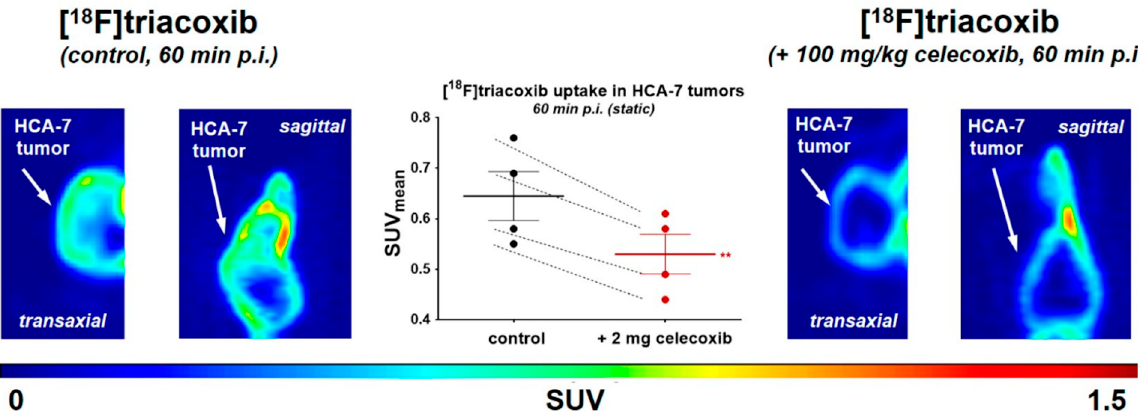
Figure 21. Transaxial and sagittal PET projection of PET images of [ 18 F]triacoxib at 60 min p.i. in the same mouse after two consecutive days under control (left) and blocking (right) conditions. Statistical analysis of the blocking effect with 2 mg celecoxib at 60 min p.i. (middle). Data are presented as individual points with the mean ± SEM from n = 4 dynamic PET experiments. ** p < 0.01. Figure readapted with permission from publisher [90].